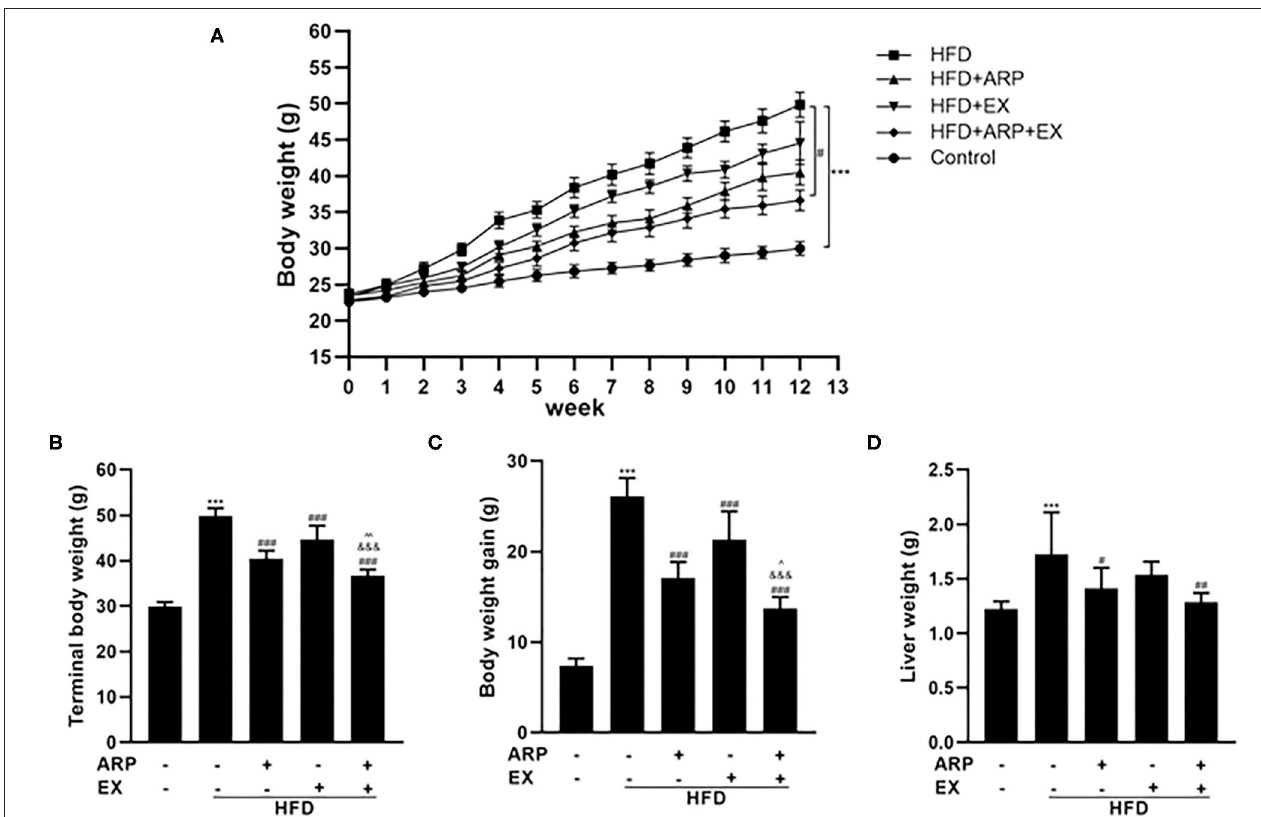
FIGURE 1 | Effects of Anoectochilus roxburghii polysaccharide (ARP) and exercise (EX) on body and tissue weights in high fat diet (HFD)-fed mice. (A) The curve of body weight, (B) terminal body weight, (C) body weight gain, (D) liver weight in C57BL/6 mice feeding HFD. All the values are exhibited as the mean ± SME, n = 8. *** p < 0.001 vs. related control group. # p < 0.05, ## p < 0.01, ### p < 0.001 vs. related HFD group; ∧ p < 0.05, ∧∧ p < 0.01 vs. related HFD + AR group; &&& p < 0.001 vs. related HFD + EX